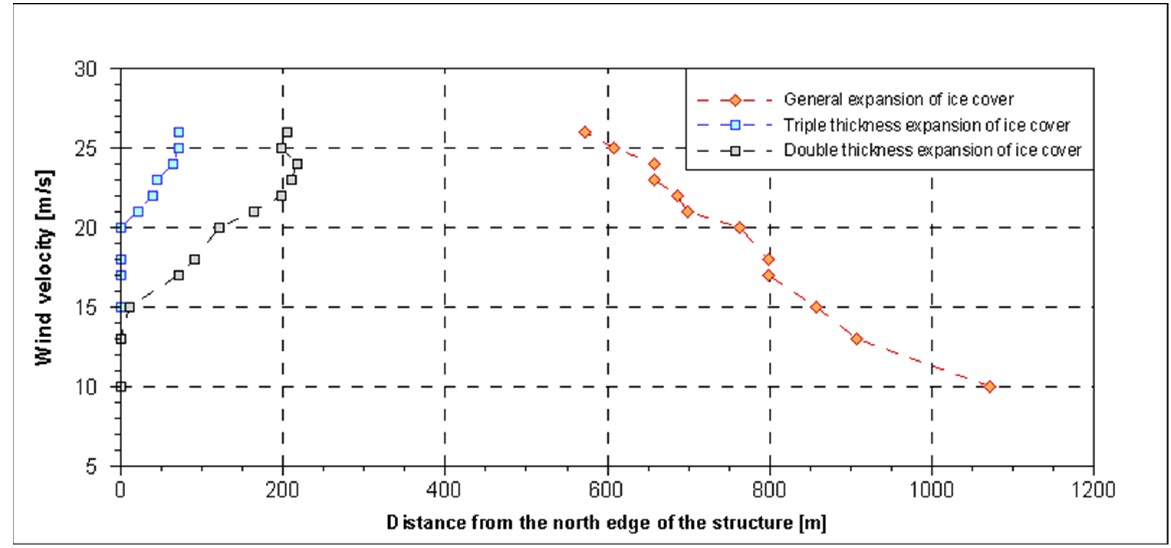
Figure 11. Expansion of ice and the location distance of double thickness and triple thickness to the structure. Double thickness of ice cover location indicates the power of wind to contract the ice cover. The farther from the structure it is, the more powerful the wind act on ice shrinking. At the rage of less than 13 m/s, no double ice thickness is observed; after 13 to 15 m/s, it appears at the instant vicinity of the structure. From 15 to 17, it recedes abruptly to 71 m of the structure, due to the mentioned ice shifting by the wind. Between 17 and 21 m a slight curved increment to the distance takes place (to 164 m). From 22 to 24 m/s, a mild linear increment in the distance happens, which is followed by a reduction in the distance in 25 and 26